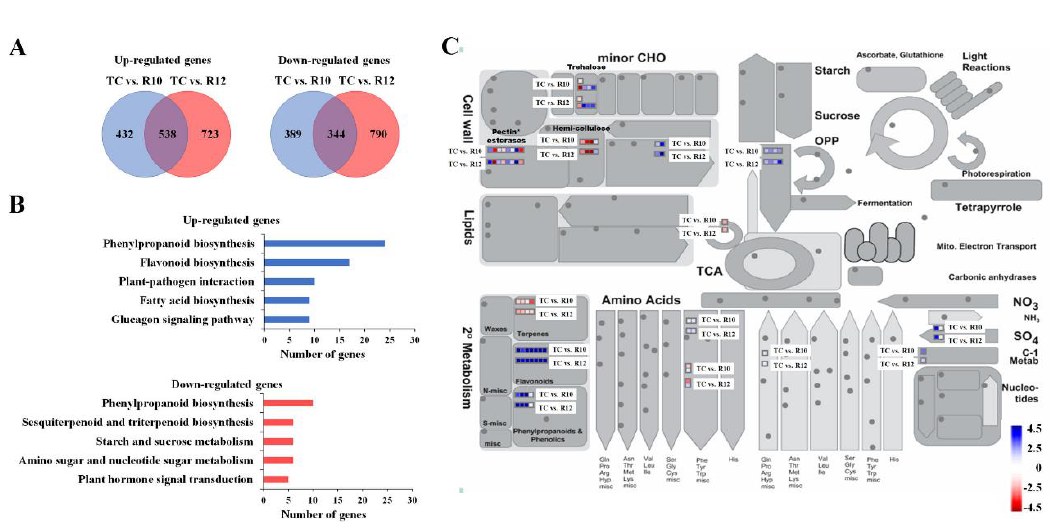
Figure 2. Analysis of differentially expressed genes (DEGs) induced by PAP1 overexpression. ( A ) Venn diagram of DEGs (TC vs R10 and TC vs R12). KEGG pathway enrichment analysis ( B ) and MapMan metabolism overview ( C ) using 882 DEGs, which were up- or down-regulated DEG in both PAP1 -overexpressing hairy root lines. The different colors represent the log2 values of expression levels of DEGs. Transgenic lines: R10 and R12; Transgenic control: TC.